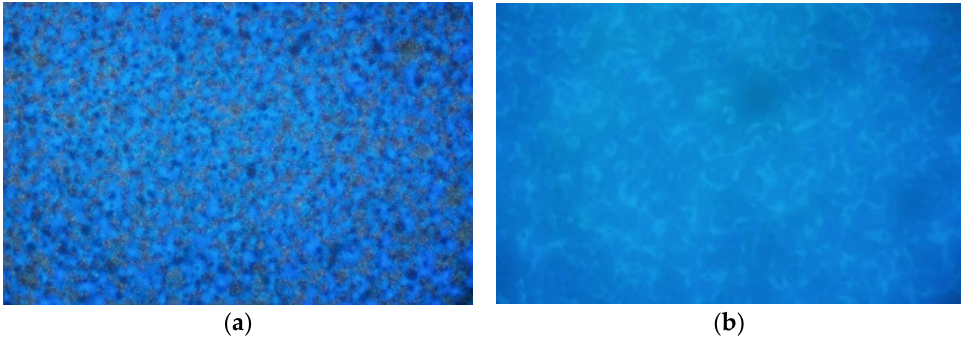
Figure 10. Fluorescent micro-structure of WE/A with 25% WER ( a ) 1 h; ( b ) 48 h.